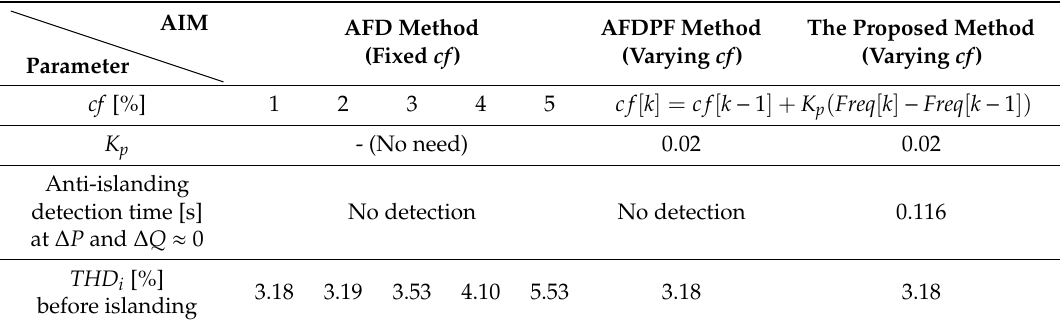
Figure 10. Anti-islanding test results when the proposed method is used. Table 3. Performance comparison among AIMs.